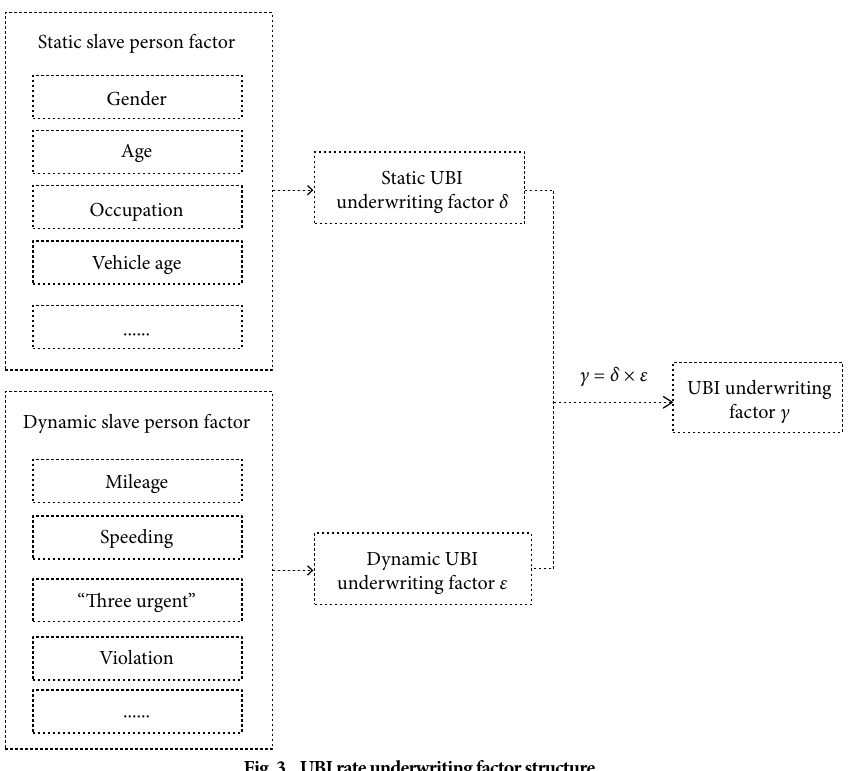
Fig. 3 UBI rate underwriting factor